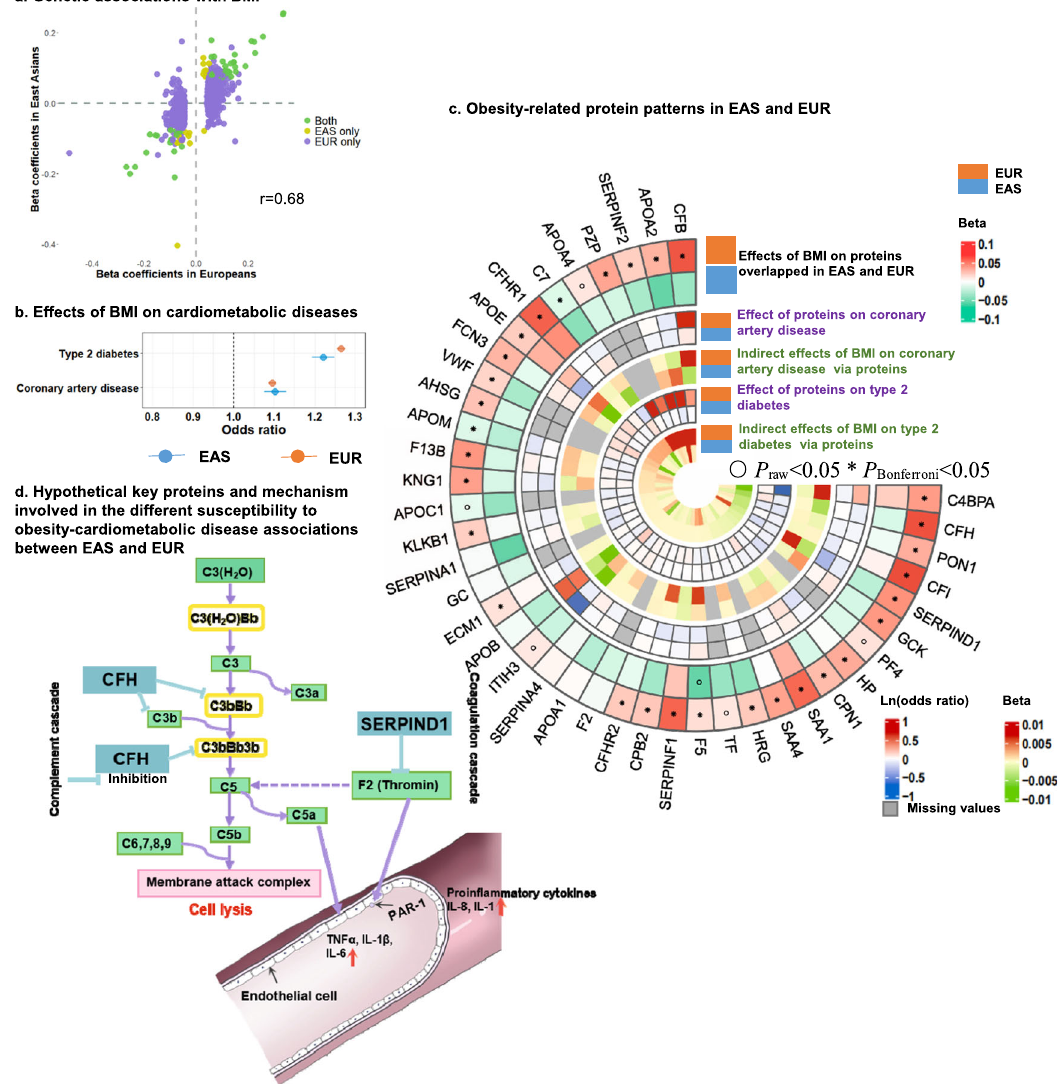
Fig. 7 | Putative mechanism for difference in BMI-induced type 2 diabetes and coronaryarterydiseasesusceptibilitybetweenEuropeansandEastAsians. The analysis comprised 41 proteins with pQTLs in two populations. a Shared genetic architecture among two populations. EAS, East Asian; EUR, European. b Effect of BMIoncardiometabolicdiseaserisk.Theeffectsizesarepresentasoddsratiosper 1 kg/m 2 increase inBMI. The dots representtheestimated effectsize,andthe lines